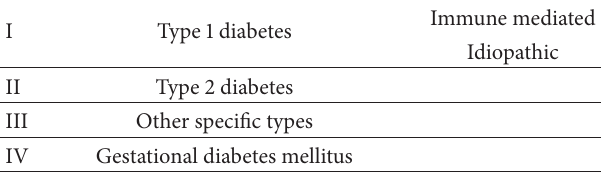
Table 1: Classification of diabetes by ADA [1].